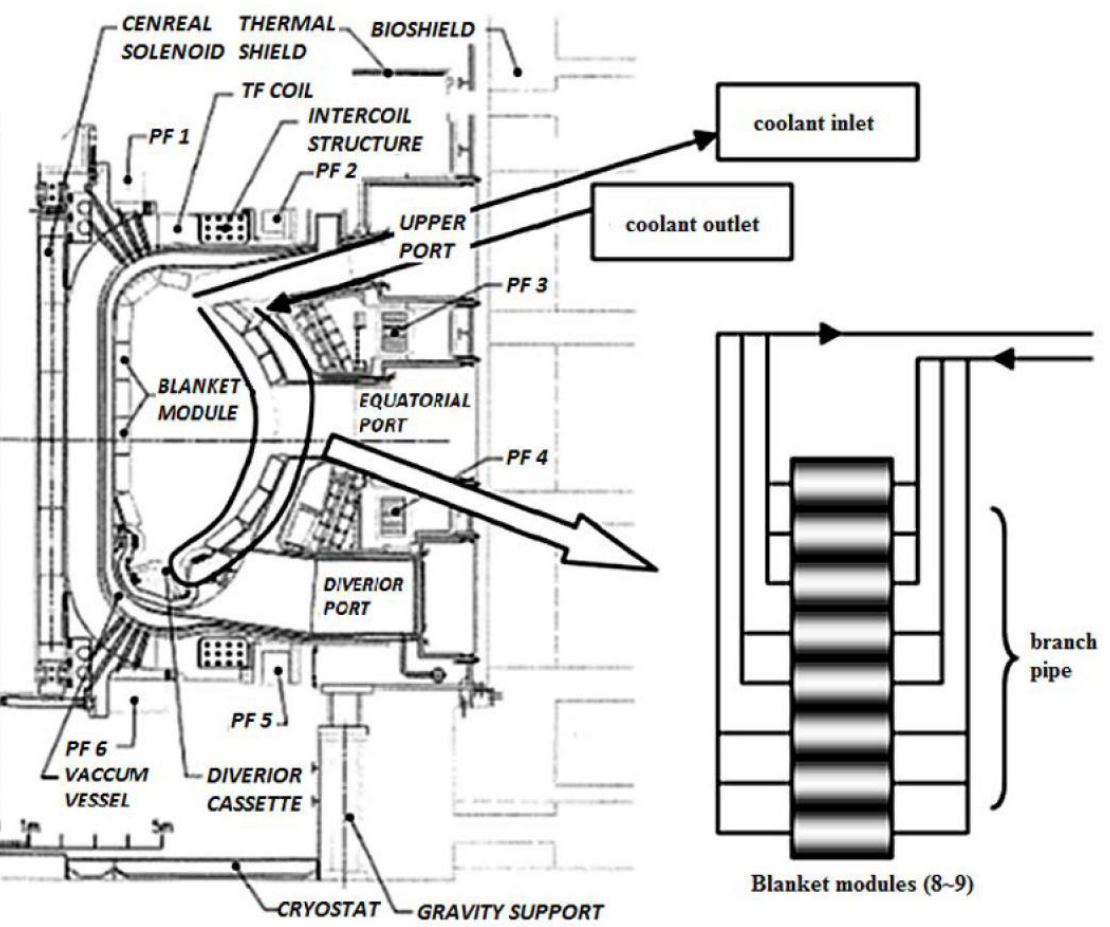
Figure 16. Cooling flow loop for the blanket cooling system (after Sato et al. [25]). © 2006 ITER Organization. This image is hereby used courtesy of the ITER Organization.